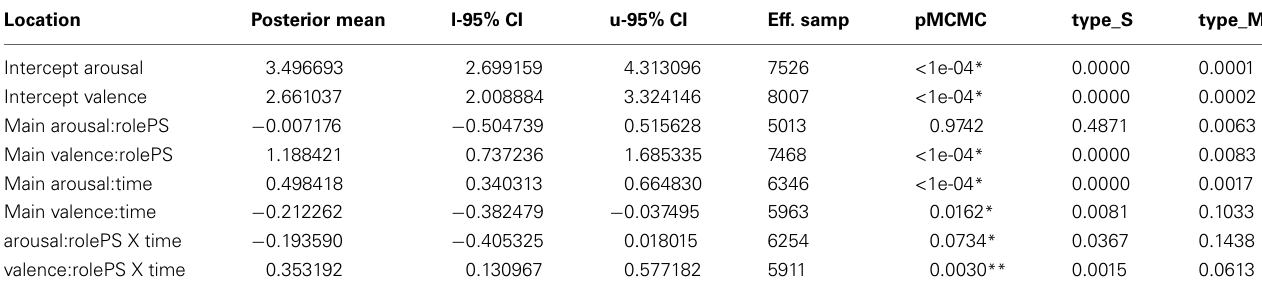
Table 3 | Locations for effects modeled as fixed in the MCMC analysis, along with the probabilities of sign errors (type S ) and magnitude errors (type M ).